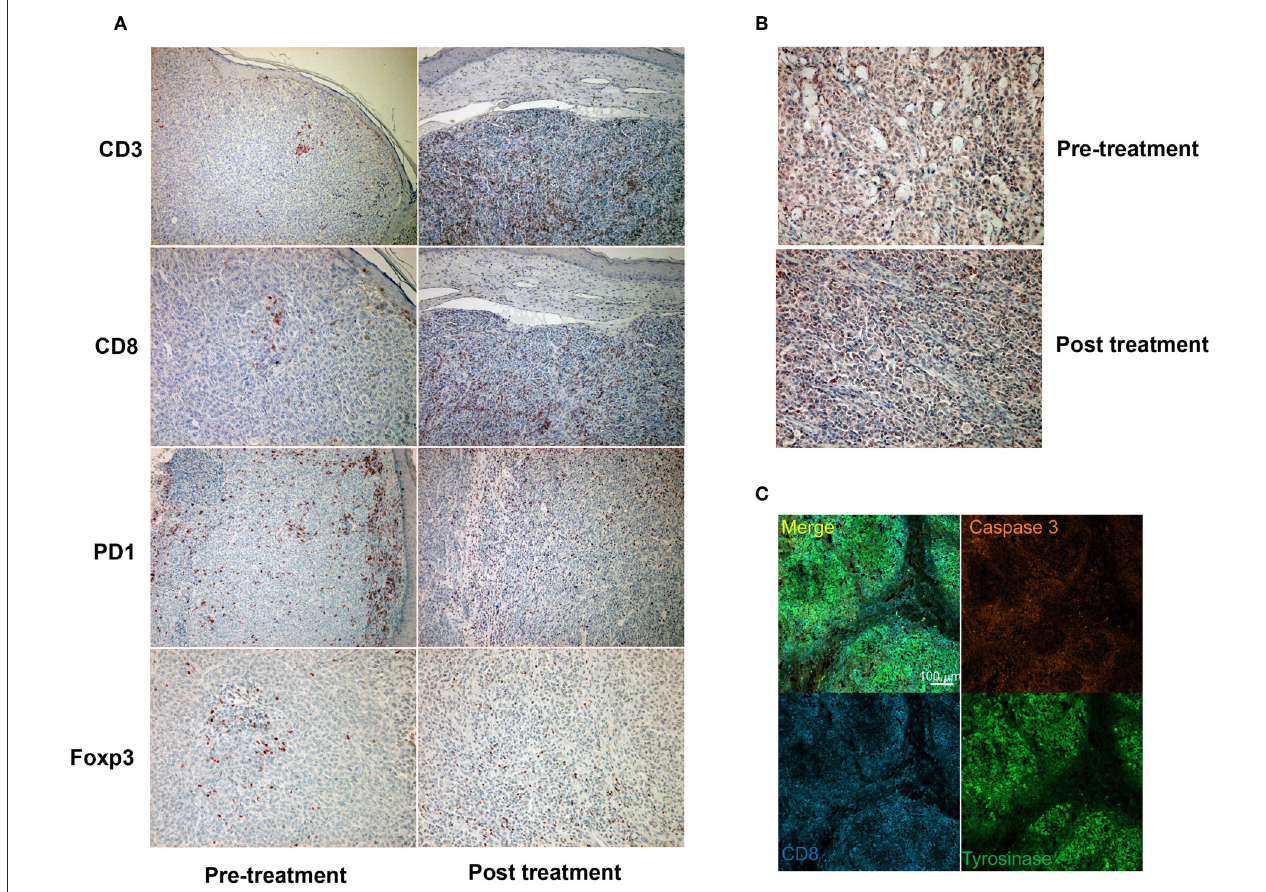
FIGURE 2 | Immunohistochemical staining for CD3, CD8, PD1, and Foxp3 before and after a single administration of nivolumab with ipilimumab (A) . Immunohistochemical staining for PD-L1 before and after a single administration of nivolumab with ipilimumab (B) . Immunofluorescence staining of CD8 (cytotoxic T cells: blue), caspase 3 (apoptotic cells: orange), and tyrosinase (melanoma cells: green) (C) .